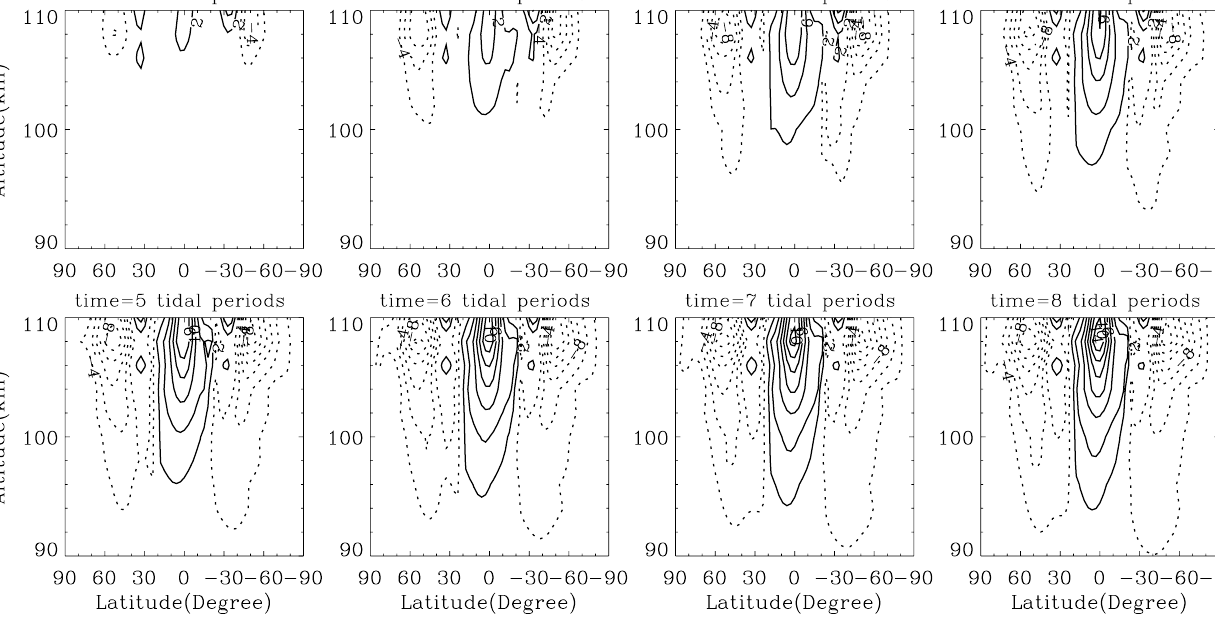
Fig. 2. Temporal evolution of the zonal-wind amplitude difference (specified by subtracting the GSWM-00 results from the nonlinear model results) within 8 tidal periods for March deduced from the nonlinear propagation solution of the migrating semidiurnal tide starting from the GSWM-00 tidal oscillations. The intervals of the contours are 2ms − 1 . The solid and dotted curves denote the positive and negative values,